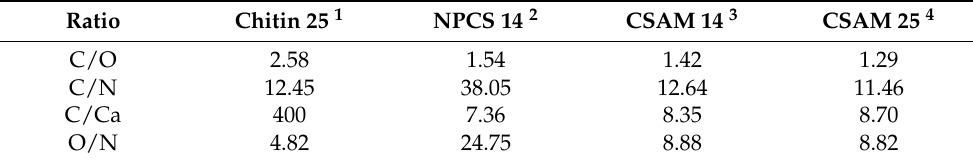
Table 1. XPS results comparison of samples after various grinding passes.